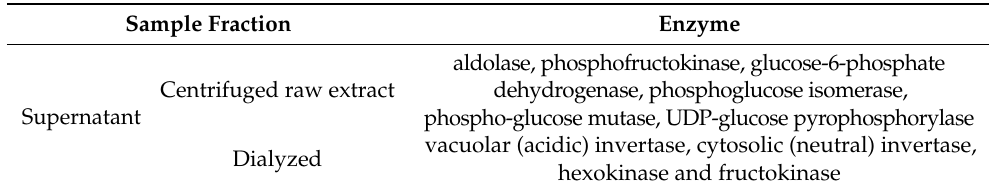
Table 1. Schematic representation of fractions after disruption of cells and centrifugation used for the analysis of enzyme